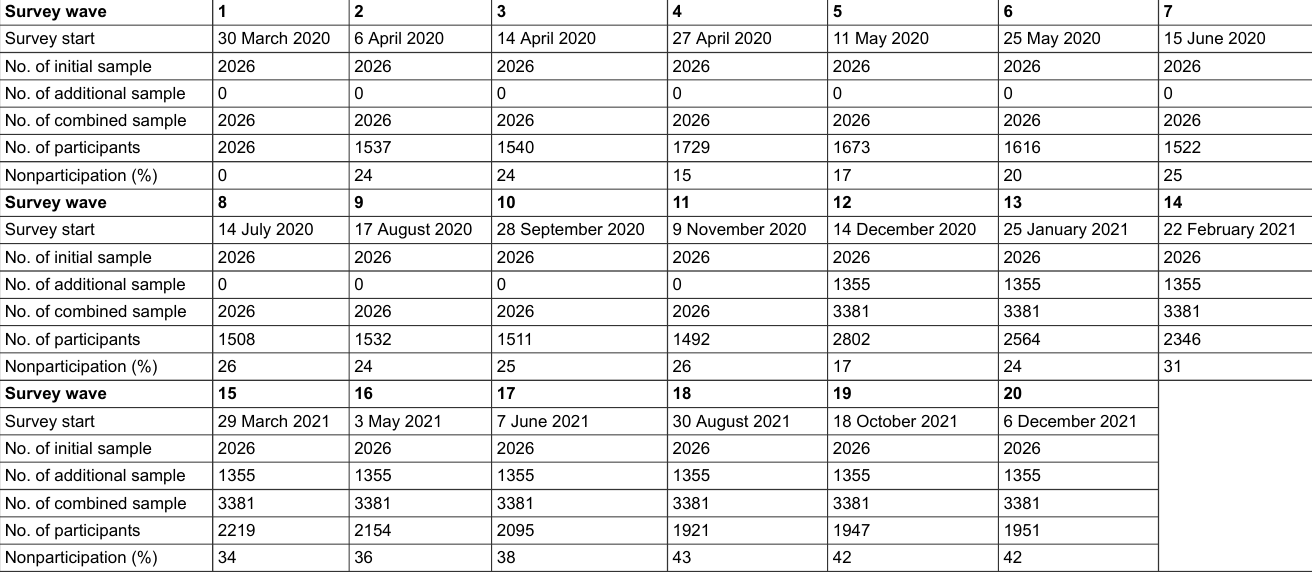
Table 1: Overview of COVID-19 Social Monitor sample size and nonparticipation by wave. Survey